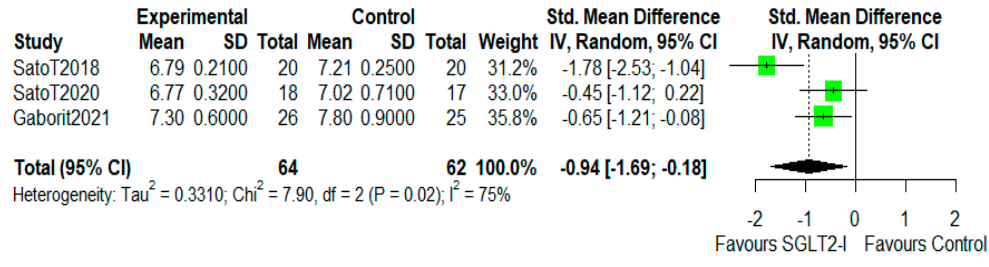
Figure 3. Effect of SGLT2 inhibitor therapy on body mass index (BMI). Fixed − effects, standardized mean difference (SMD), 95% confidence intervals (CI), and I2 statistics.